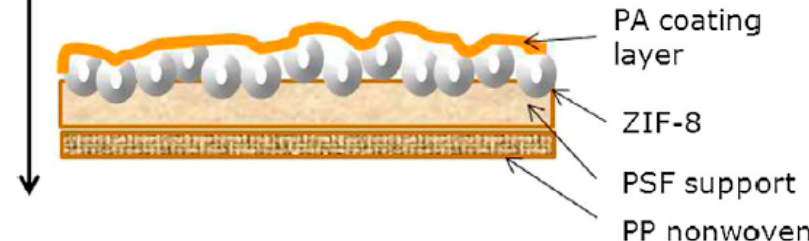
Figure 5. Schematic diagram representing the layer-bay-layer (LBL) technique for the preparation of ZIF-8-MMM [29].